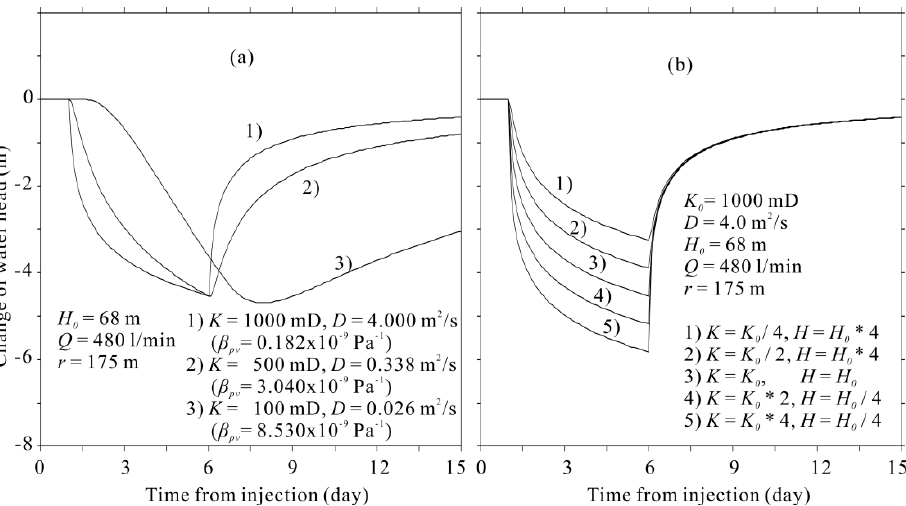
Figure 6. Water head changes estimated from the theoretical solution of a 2D radial flow in a homogeneous and isotropic infinite horizontal layer for pumping at a rate of Q = 480 L/min calculated at a distant of r = 175 m. ( a ) Results for different permeability ( K ) and hydraulic diffusivity ( D ). ( b ) Results for different permeability ( K ) and layer thickness ( H ).